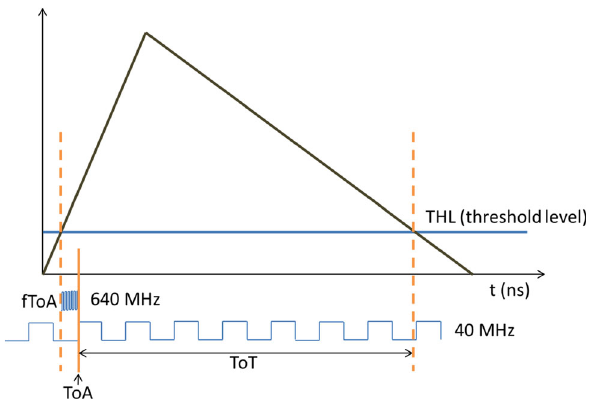
Fig. 1 PrincipleofthetimeandenergydetectionofaTimepix3readout